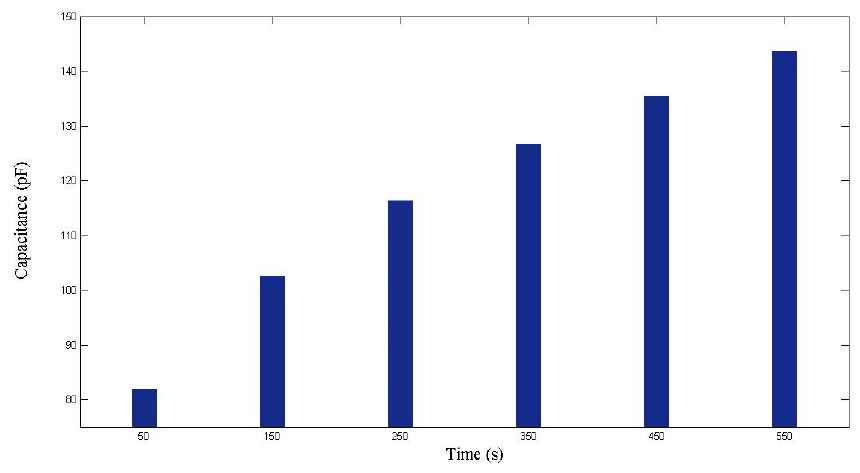
Figure 10. Capacitance measured during the first RTM experiment using a nine-layer fiber preform.